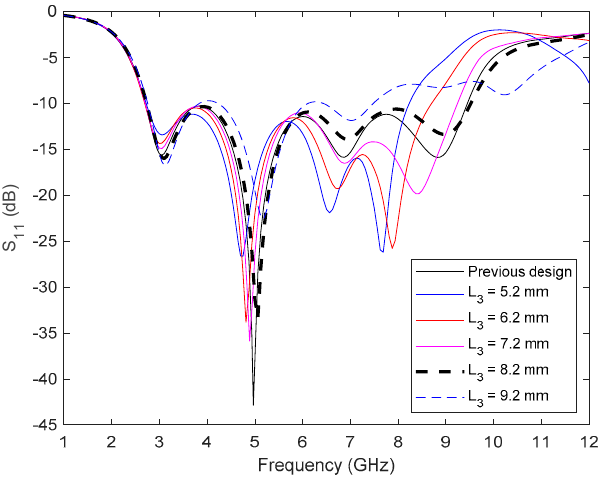
Figure 5. Antenna reflection coefficient for different values of L